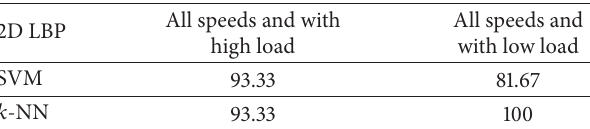
Table 10: The performance of classifiers for VSFL model when the 2D LBP scheme is used for feature extraction.